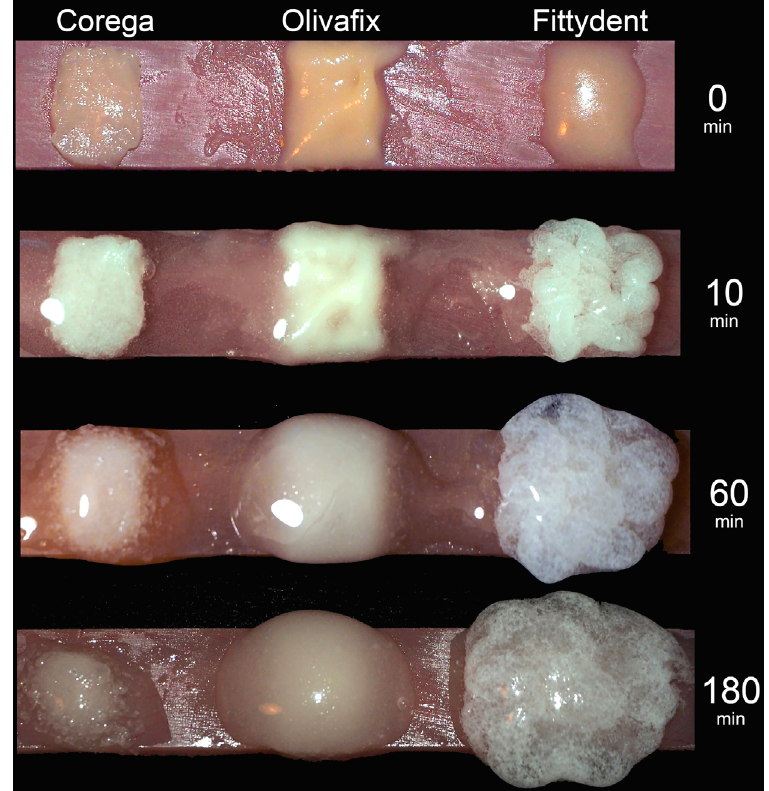
Figure 5- Photos of adhesives on a PMMA bar at 0 min, 10 min, 60 min and 180 min after their wetting with a water spray